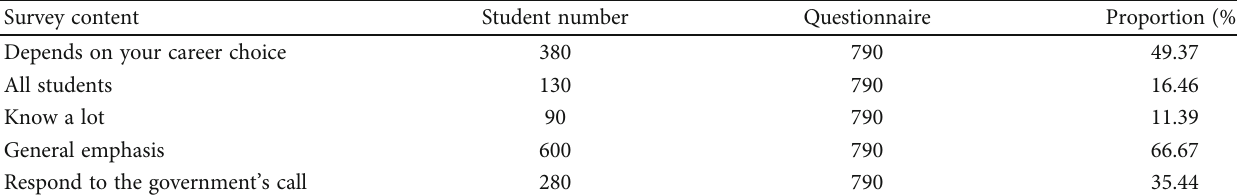
Table 1: Overall understanding of college students ’ innovation and entrepreneurship education.